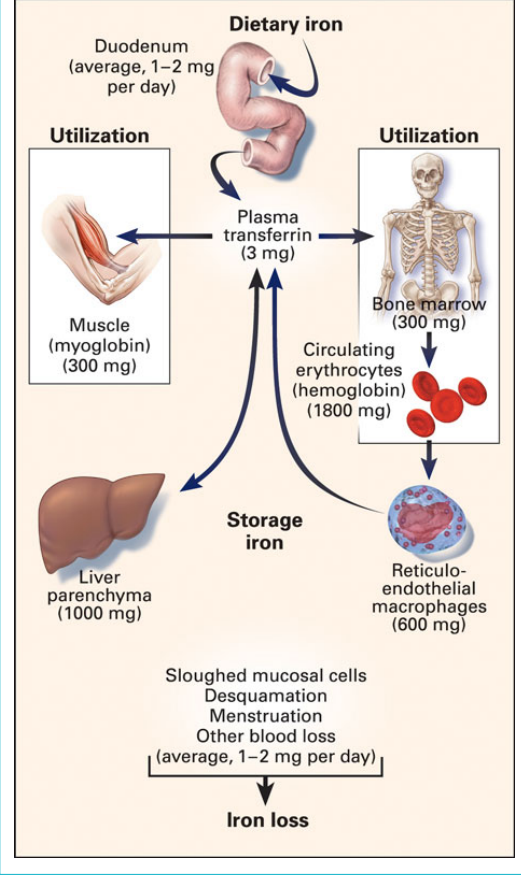
Figure 1: Intake, distribution and loss of iron in adults.From: An- drews NC. Disorders of iron metabolism. N Engl J Med. 1999;341:1986–95 [18]. Copyright © (1999) Massachusetts Med- ical Society. Reprinted with permission from the Massachusetts Medical Society.